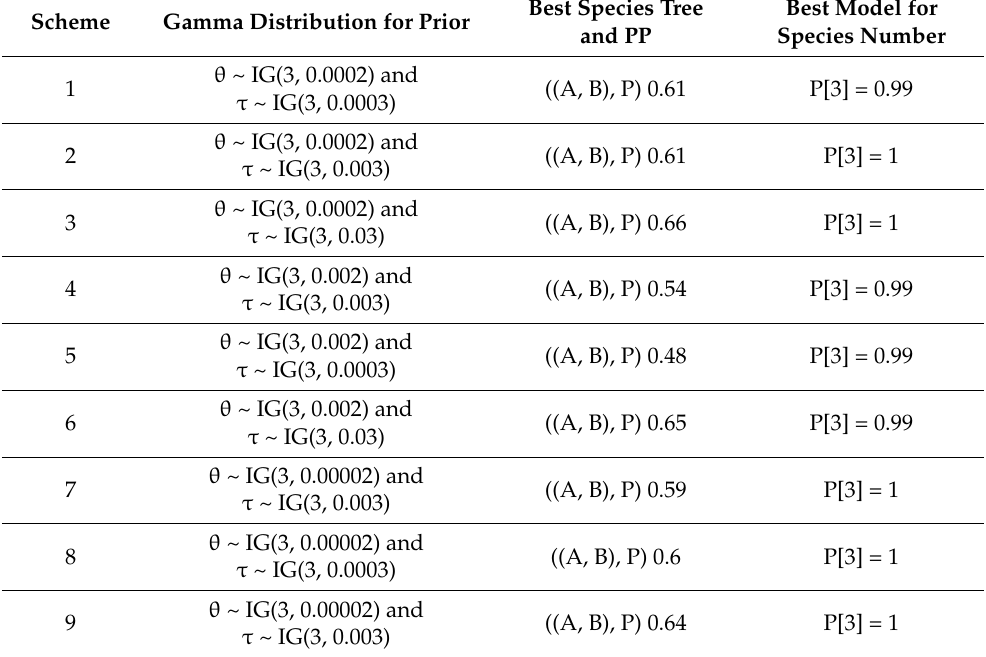
Table 1. Prior schemes tested in BPP. Priors for scheme 1 were estimated from the data and the other schemes were used to test the effects of different priors and were set to allow the parameters means to vary over two degrees of magnitude. Additionally, the best models for the species tree and the number of species are displayed with their respective posterior probabilities (PP) values. Best Species Tree Best Model for Scheme Gamma Distribution for Prior and PP Species